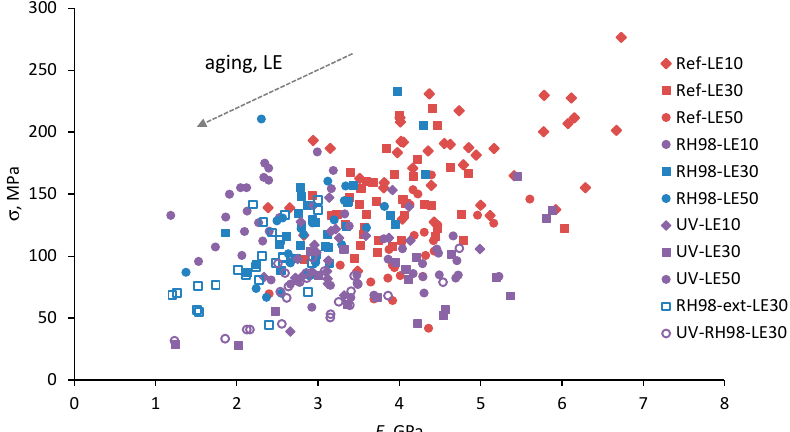
Figure 8. Strength versus the elastic modulus for wool fibers of different lengths (LE) from different environments.